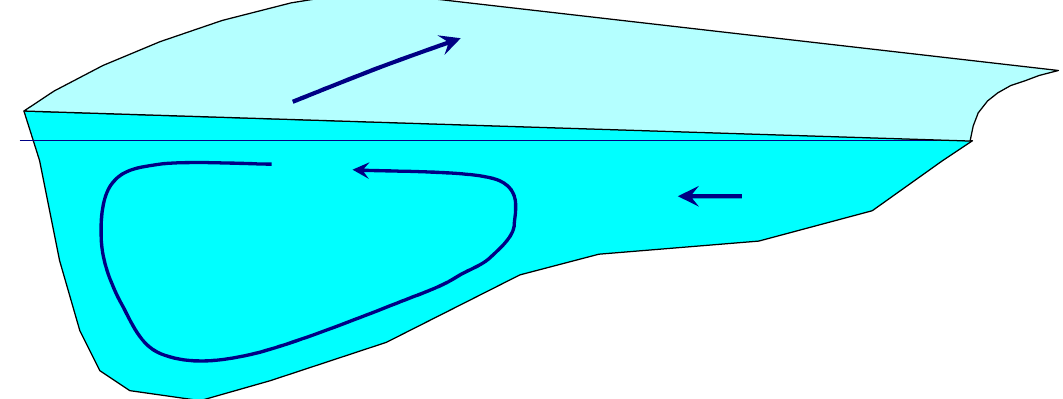
Figure 2. Typical river channel cross section with super elevation around a meander bend that causes a pressure imbalance and induces a secondary flow current. The arrows denote the direction of downstream flow on the water surface (light blue shading) and secondary circulation in cross section (medium blue shading)